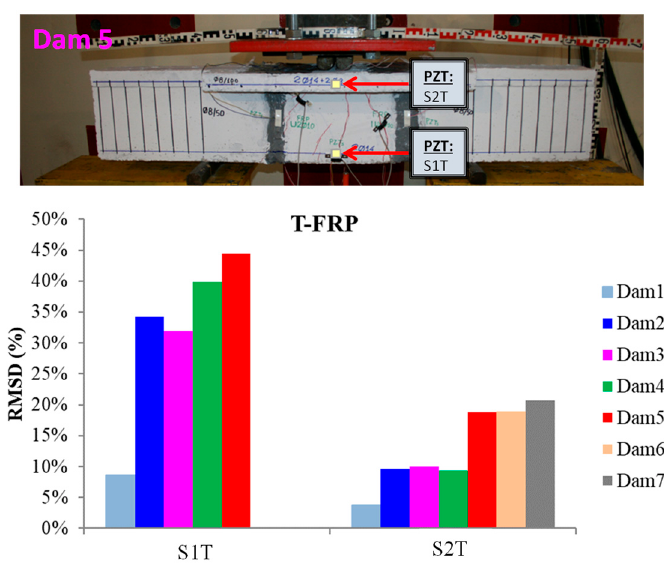
Figure 8. RMSD index values of PTZs mounted on the steel reinforcing bar of T-FRP.